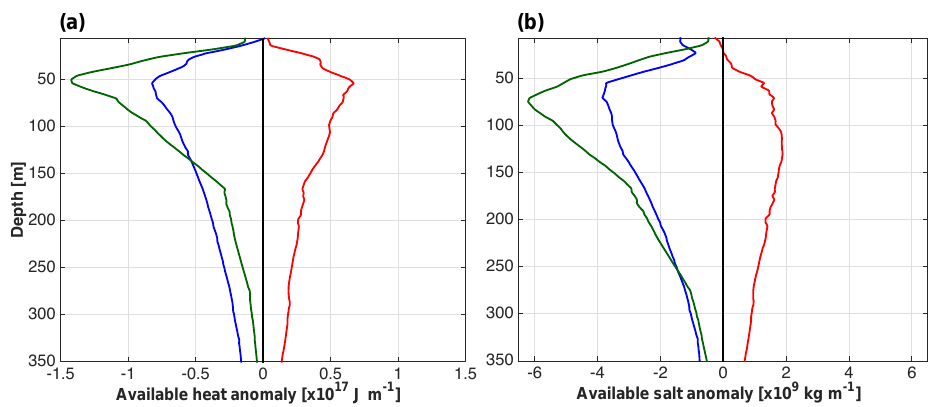
Figure 13. Mean profiles of available (a) heat and (b) salt anomaly per meter of the composite cyclone (blue line), anticyclone (red line), and ACME (green line).